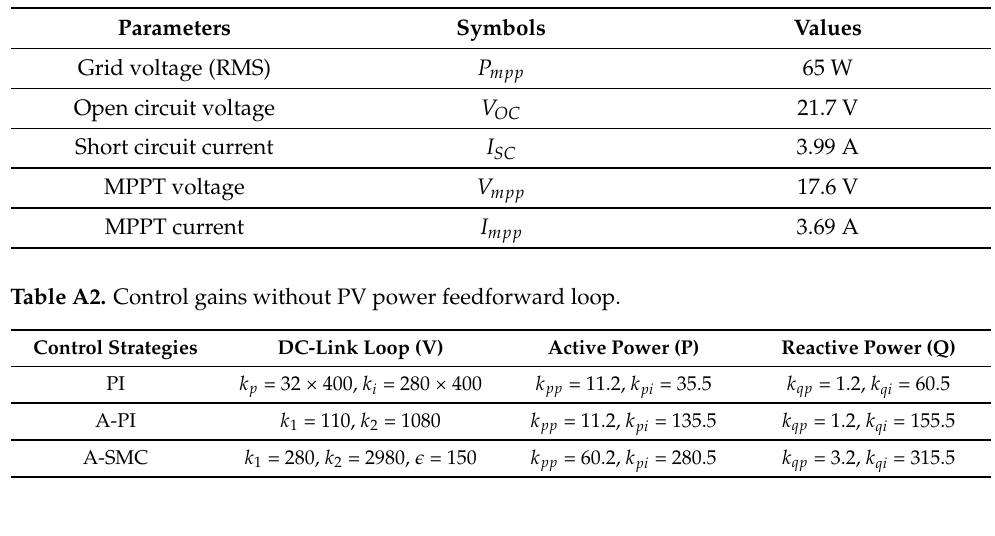
Table A1. PV panel nominal parameters.